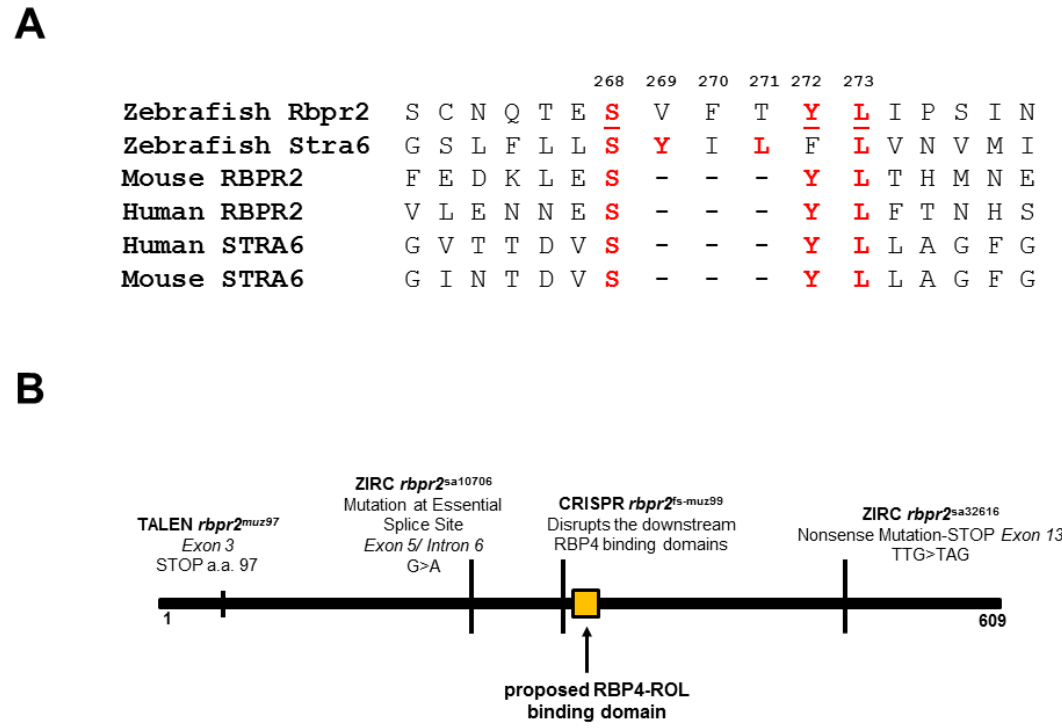
Figure 1. Proposed RBP4 binding residues on zebrafish Rbpr2 for retinol transport. ( A ) A proposed RBP4 binding domain (SYL) in Rbpr2 is conserved among species. This RBP4 binding domain occurs in exon 8 of Rbpr2. Overall amino acid identity between STRA6 and Rbpr2 among species is < 22% based on this alignment. ( B ) Schematic representation of zebrafish Rbpr2 cDNA. Location of mutations in rbpr2 mutant zebrafish lines generated or acquired previously in relation to the proposed RBP4 binding domain are shown.